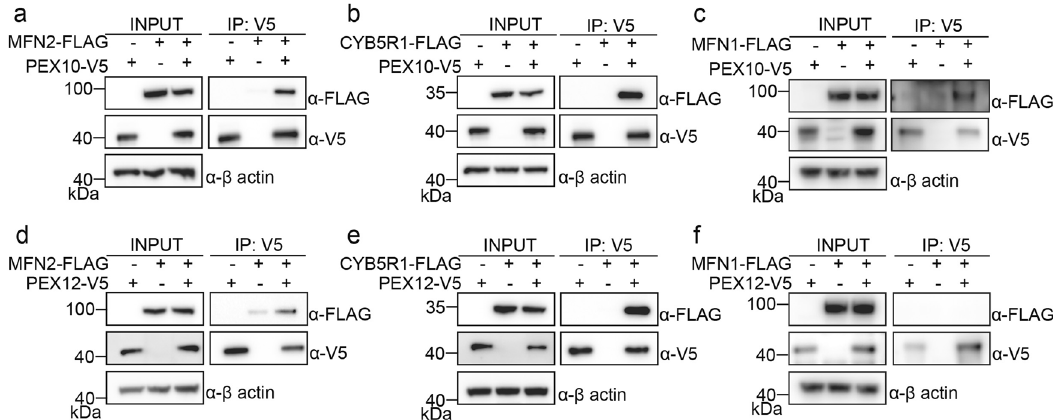
Fig. 2 PEX10 and PEX12 interact with MFN proteins. a Co-immunoprecipitation (IP) of PEX10 and MFN2. V5 tagged PEX10 was co-transfected with FLAG-tagged MFN2 in HEK293T cells. Cells were collected 36 h after transfection for IP of PEX10-V5 and immunoblotting (IB) with indicated antibodies. Cell lysates and immunoprecipitated proteins were loaded with same amount on multiple gels for different blots. Similar co-immunoprecipitation experiments were performed for PEX10 and CYB5R1 ( b ), PEX10 and MFN1 ( c ), PEX12 and MFN2 ( d ), PEX12 and CYB5R1 ( e ), and PEX12 and MFN1 ( f